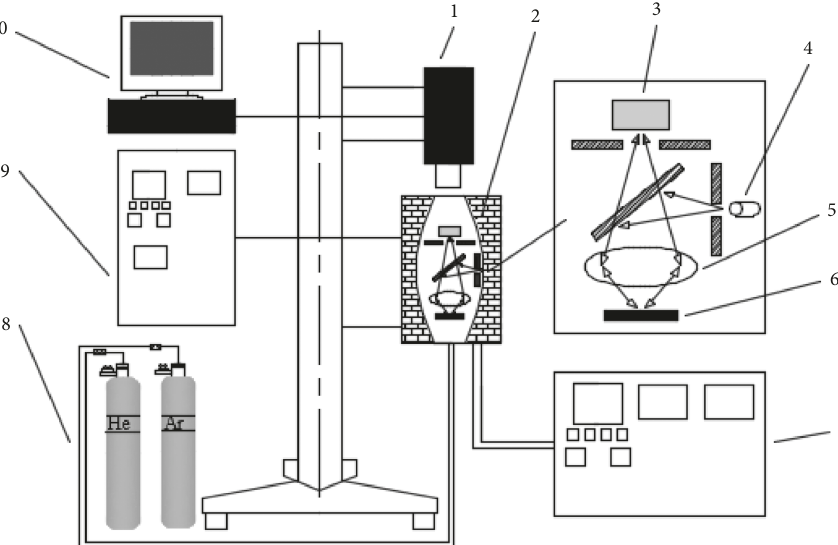
Figure 1: The schematic diagram of the experimental apparatus (1, optical system; 2, furnace; 3, thermal insulation; 4, light source; 5, lens; 6, Al 2 O 3 sheets; 7, temperature control system; 8, gas; 9, water cooling system; 10, computer).